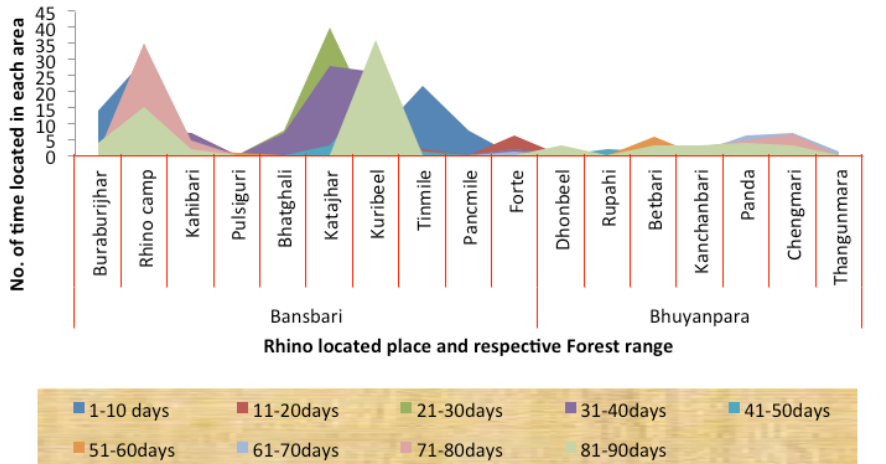
Figure 7. Colonization pattern of the 3 rd group of rhino